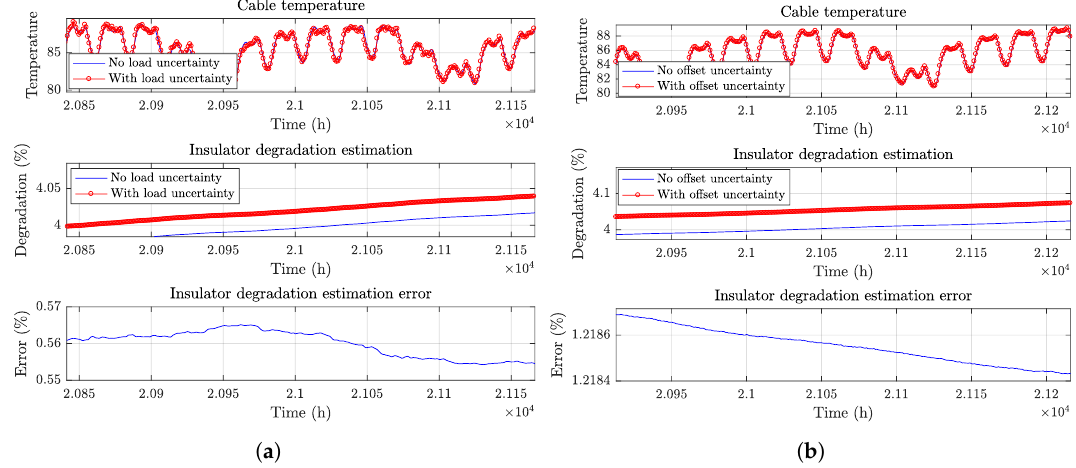
Figure 20. Effect on the degradation estimation by: ( a ) a 1% Gaussian standard deviation error on the load estimation; ( b ) a 0.2% load sensor bias.